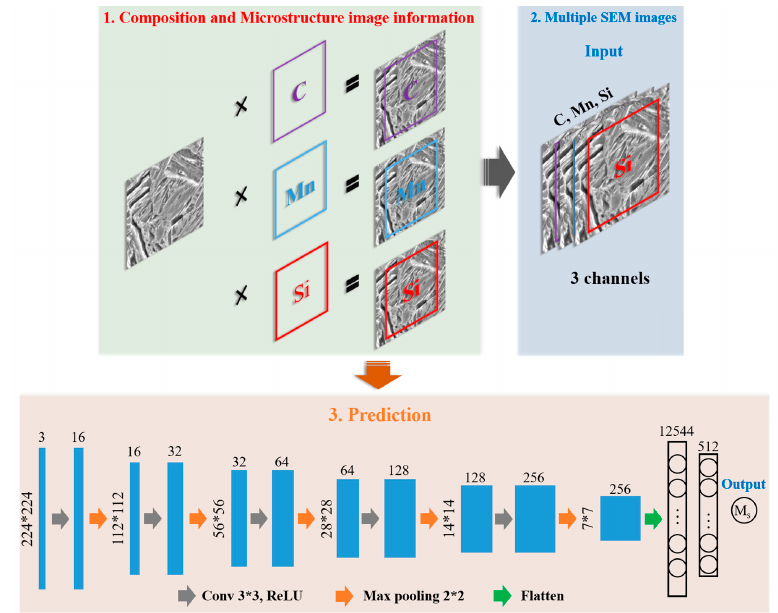
Figure 3. Framework of the CNN model for Ms prediction.